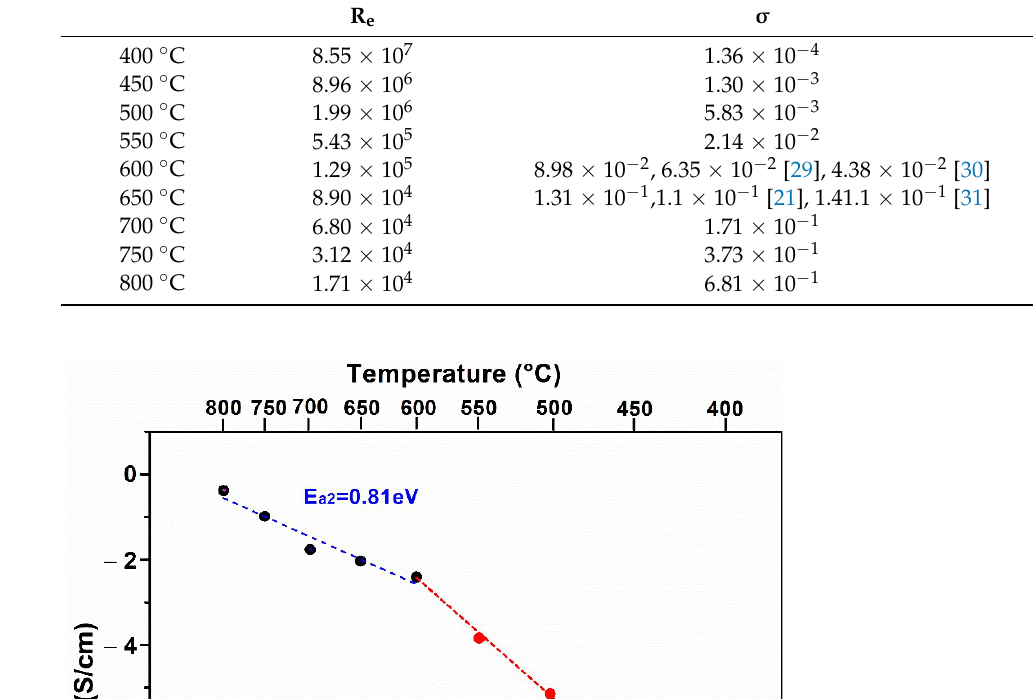
Table 3. The conductivity and resistance of Bi 1.5 Y 0.5 O 3 film with a thickness of 1.72 µ m.